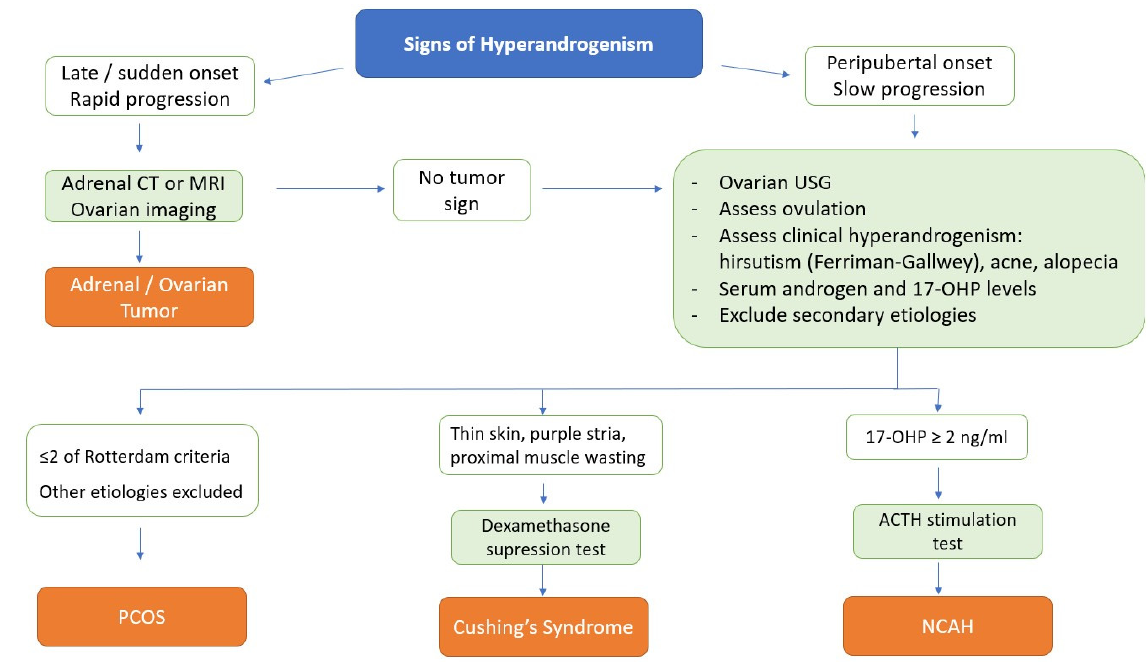
Figure 4. A differential diagnosis algorithm for hyperandrogenism.